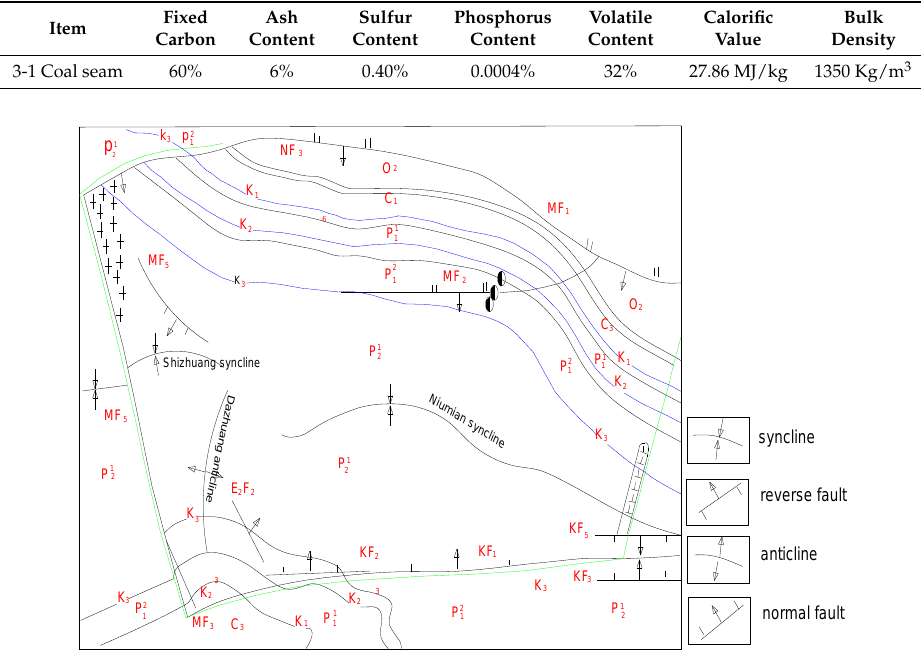
Figure 3. Geological structure outline map of the Yuan Zhuang coal mine.